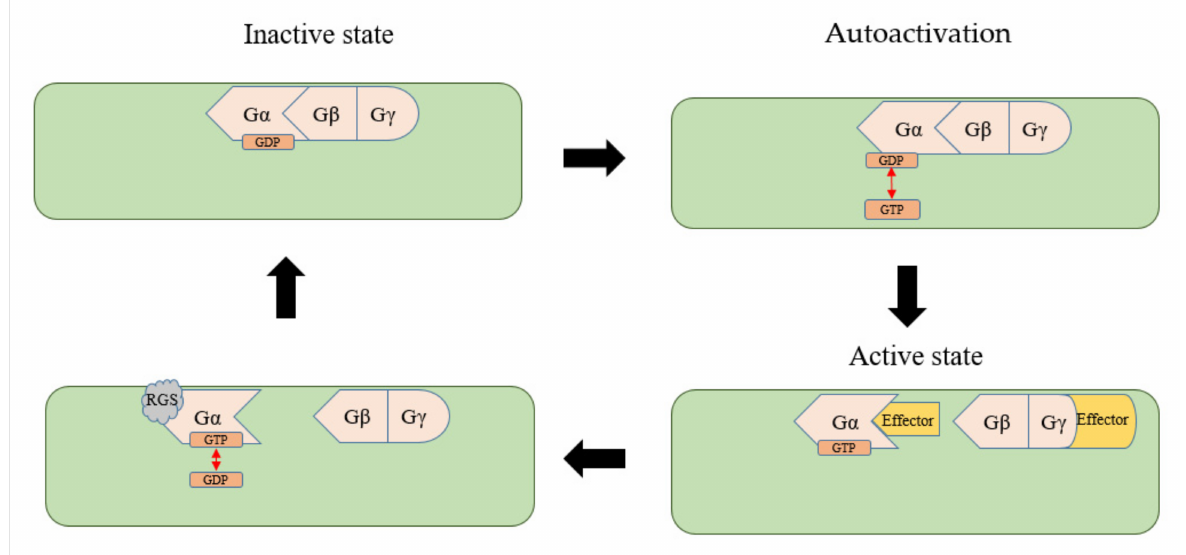
Figure 2. Traditional G-protein signaling cycle in